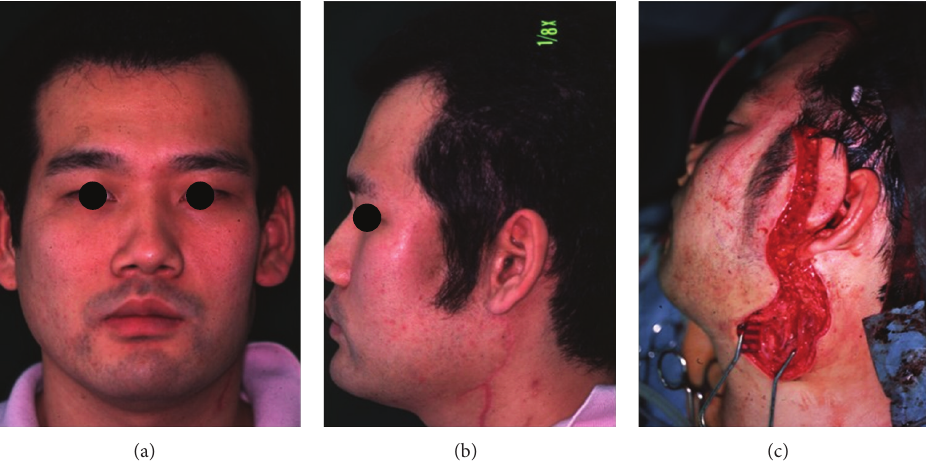
Figure 5: (a) Frontal view of the patient after tumor resection, (b) lateral view of the patient after tumor resection, and (c) intraoperative view of reconstructive surgery.